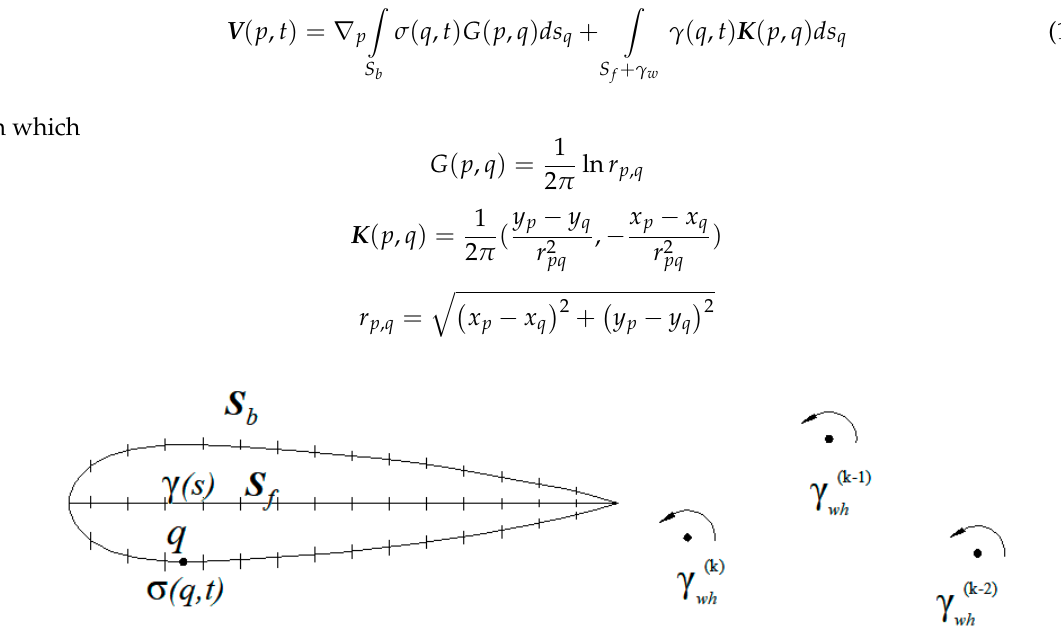
Figure 3. Elements of the h th blade at time t k .